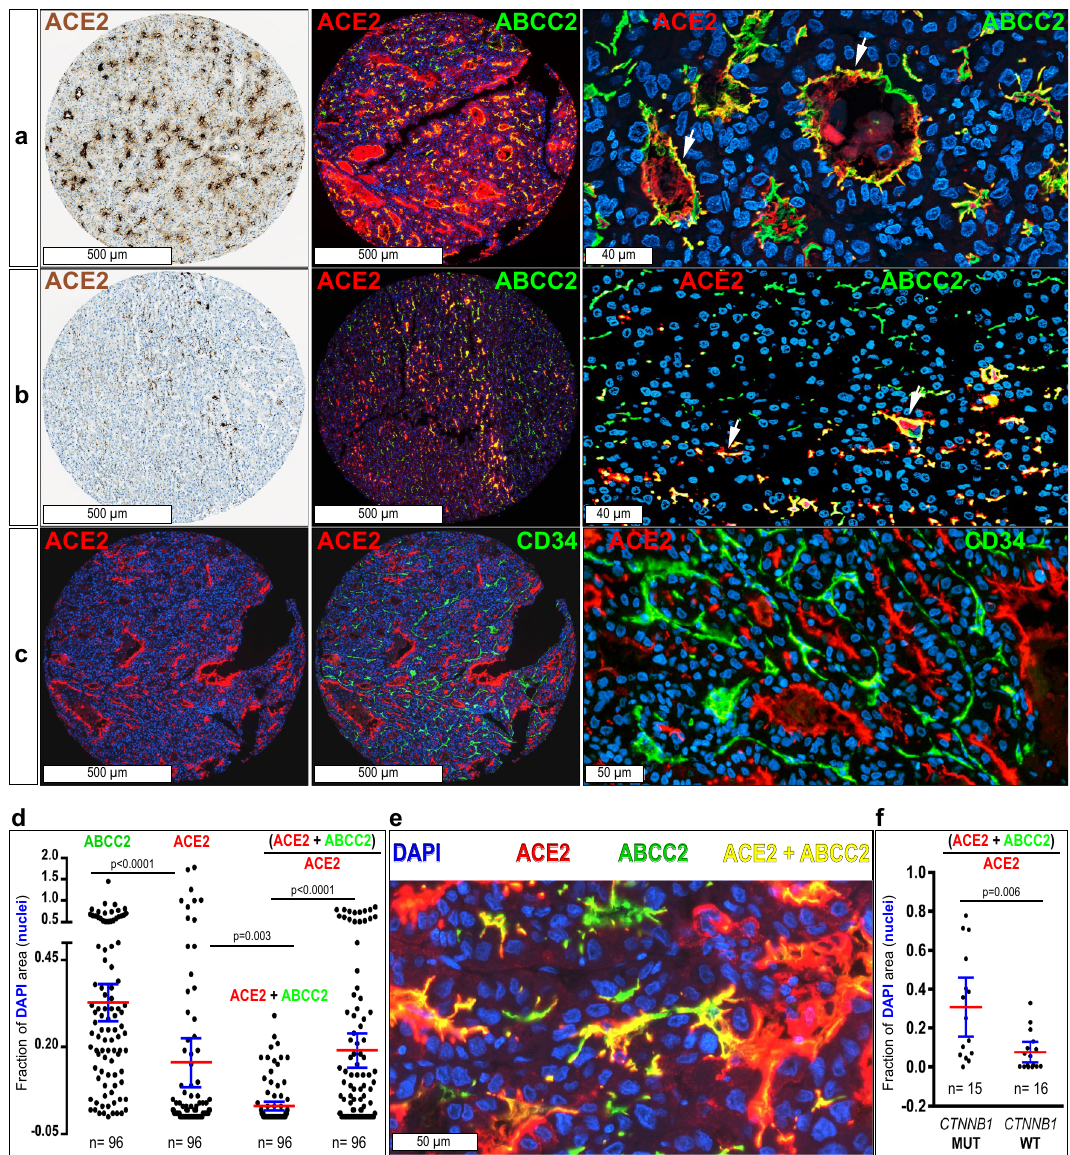
Figure 2. ACE2 is detected in the biliary pole of moderately-to-well-differentiated HCCs with trabecular or pseudo-glandular patterns. Combined immunoperoxidase and immunofluorescence analysis of a tissue microarray containing 41 HCCs and two normal liver controls, spotted in triplicates. Representative images are shown. Immunoperoxidase signal ( brown ) is counterstained with hematoxylin ( blue ) . ACE2 appears in red by immunofluorescence, other markers in green and nuclei in blue (DAPI staining). ( a ), ( b ) ACE2 colocalizes with the apical hepatocyte marker ABCC2 (a.k.a. MRP2) ( arrows ). ( c ) Tumor capillary vessels are marked with CD34. Confocal digital images were acquired with a 40X objective. Images are Z-stacks of four 500 nm focusing steps. ( d ) Quantification of ACE2, ABCC2, dual (ABCC2 + ACE2) staining and the ratio of (ACE2 + ABCC2) × ACE2 – 1 , representing the fraction of ACE2 protein expression detected as dual (ACE2 + ABCC2) staining, i.e., the fraction of overlap of ACE2 with ABCC2. Values for individual TMA spots from 32 HCCs are expressed as the fraction of DAPI staining of nuclei, to correct for natural variations in cell density in each spot. Means ± 95% confidence intervals are shown for each condition. The statistical significance between groups was calculated with Kruskal–Wallis test ( p < 0.0001), followed by the post-hoc Dunn’s test as indicated. ( e ) Sample scan from a TMA spot showing examples for the different signals quantified in ( d ). ( f ) The fraction of overlapping (ACE2 + ABCC2) over total ACE2 signal ( i.e., HCC cells expressing ACE2 at the biliary pole), is higher in HCCs carrying CTNNB1 mutations. Each data point represents the mean of two to three cores for each tumor. Statistical significance calculated by Mann–Whitney U